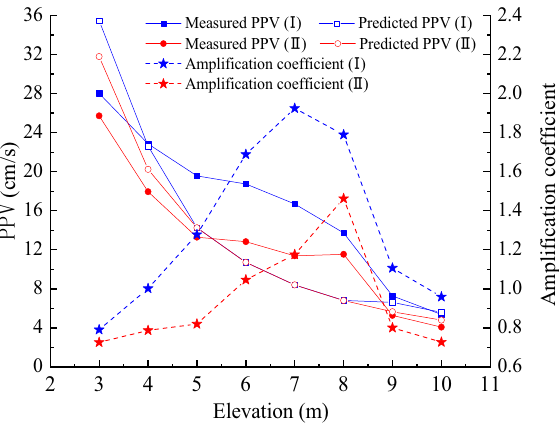
Figure 5. Elevation distribution curve for the sidewall PPV and amplification coefficient in the underground cavern in the Taohuazui mine.